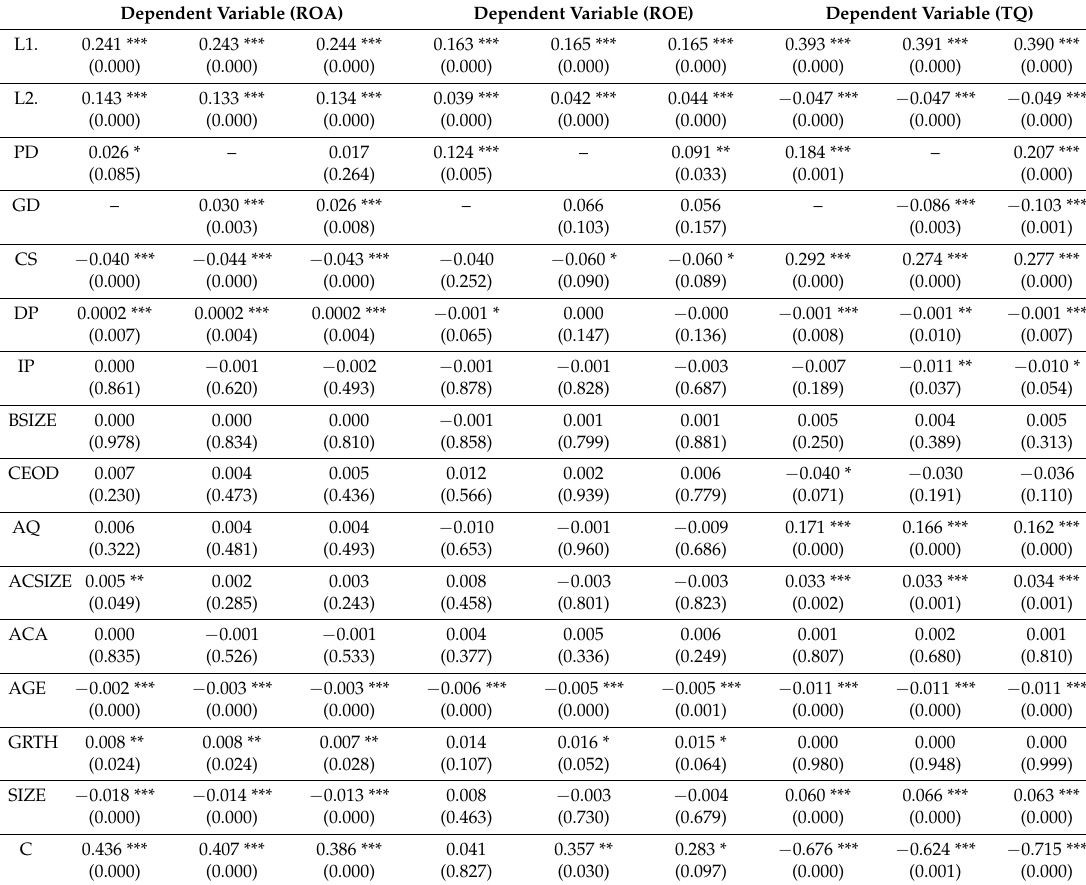
Table 5. Two-step System Dynamic Panel Regression (Overall